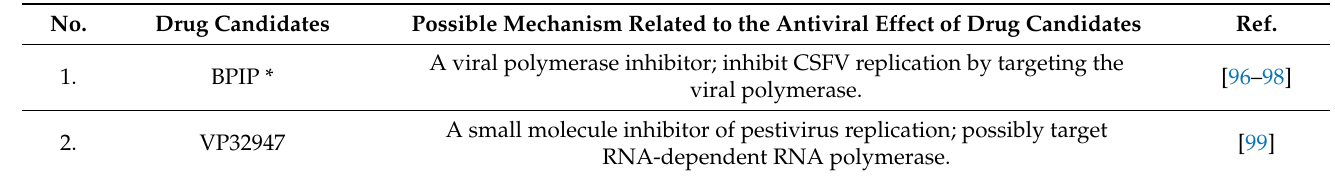
Table 3. Drug candidates with anti-classical swine fever virus (CSFV)